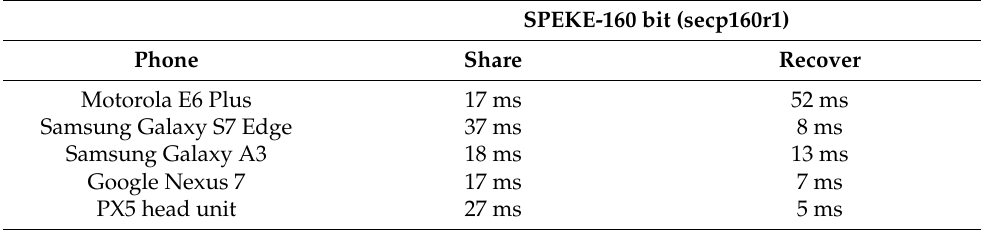
Table 3. Computational time of SPEKE in the pairing